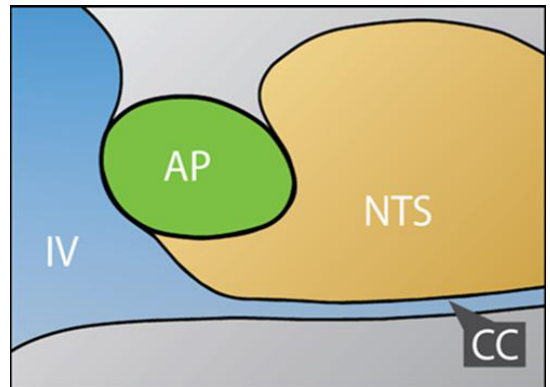
Figure 2. Sketch of a Midline-Sagittal View of Murine AP and NTS. (IV) is fourth ventricle, and (CC) is the central canal, in horizontal orientation. In mice, and presumablyin man, the subregion of the NTS that borders the AP permits neuronal contact with circulating molecules that are excluded by blood-brain barrier in most other regions of brain. The sketch is based on a figure from the Allen Brain Atlas